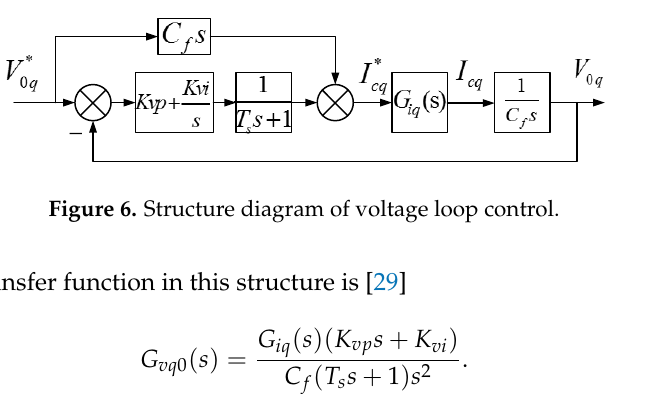
Figure 6. Structure diagram of voltage loop control.